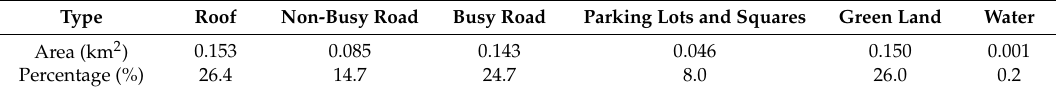
Figure 2. Hourly precipitation at Nanjing Meteorological Station from June 12 to June 13 in 1991. Table 1. Underlying surface types and proportions in the study area.